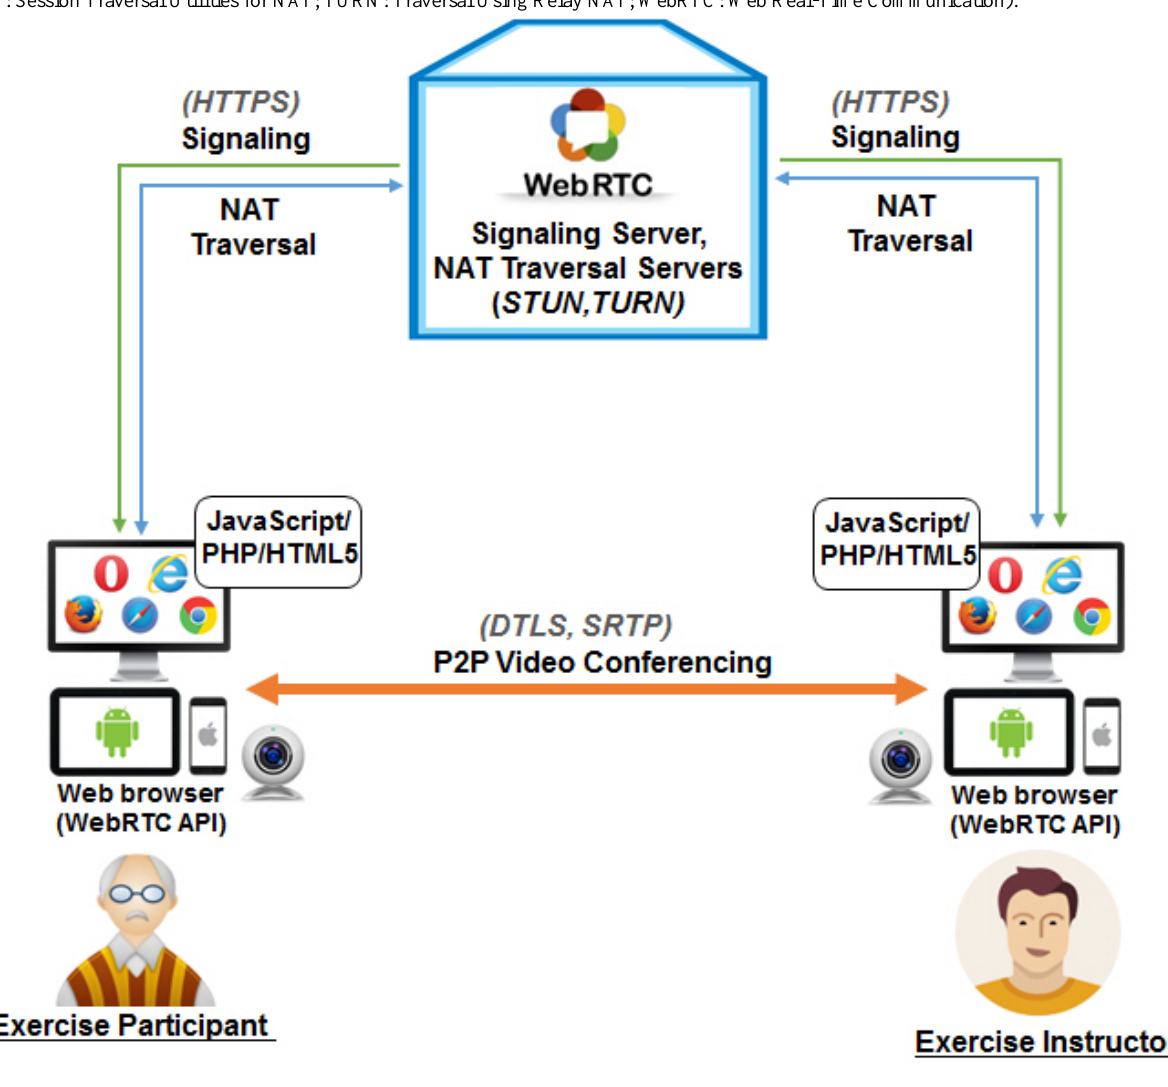
Figure 2. Overview of the telepresence exercise platform using WebRTC technology (API: application programming interface; DTLS: Datagram Transport Layer Security; HTML5: Hypertext Markup Language revision 5; HTTPS: Hypertext Transfer Protocol Secure; ICE: Interactive